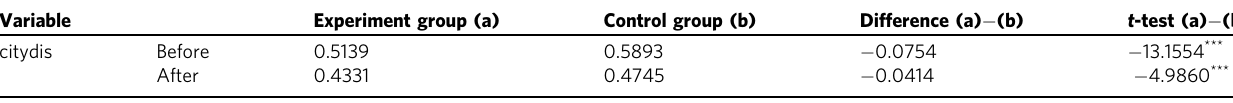
Table 2 Result of univariate t test.